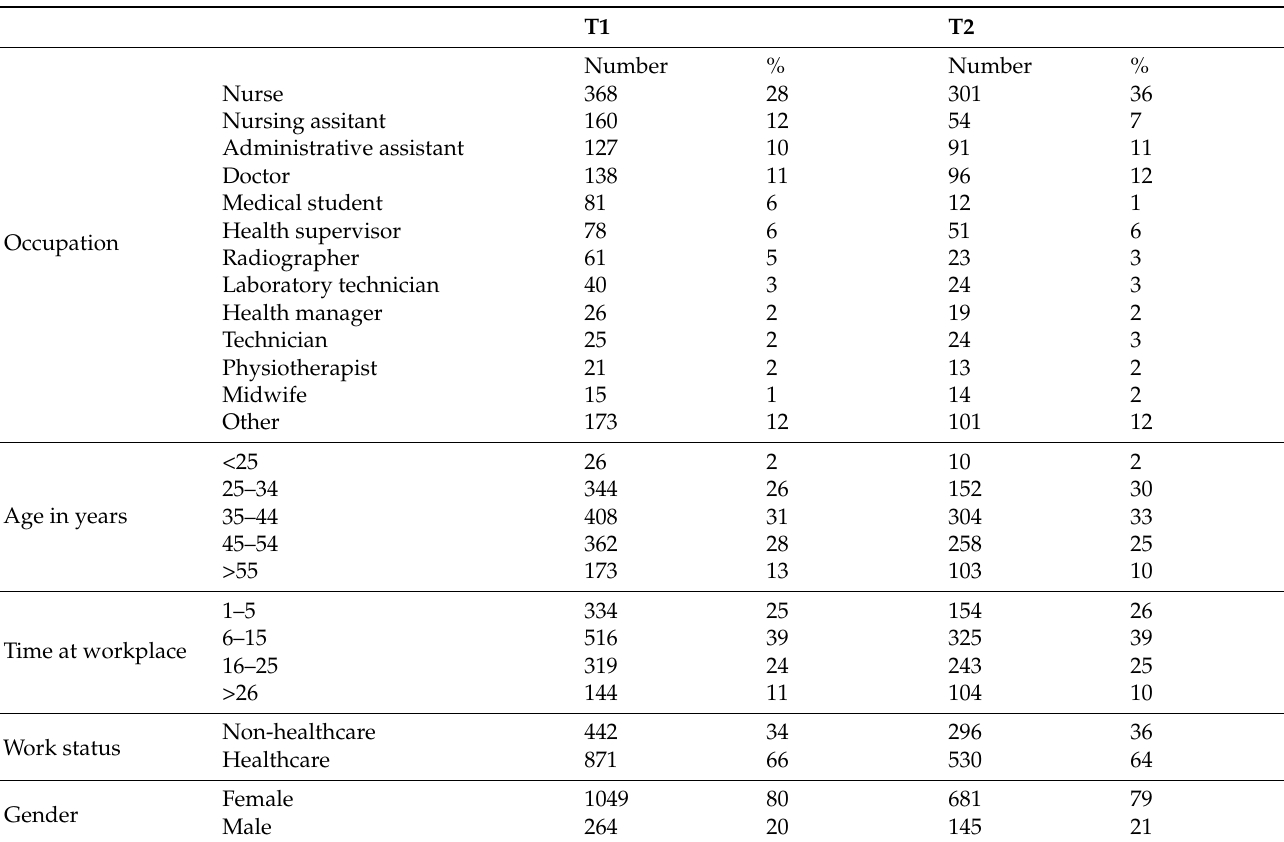
Table 1. Demographics and occupational characteristics of population.